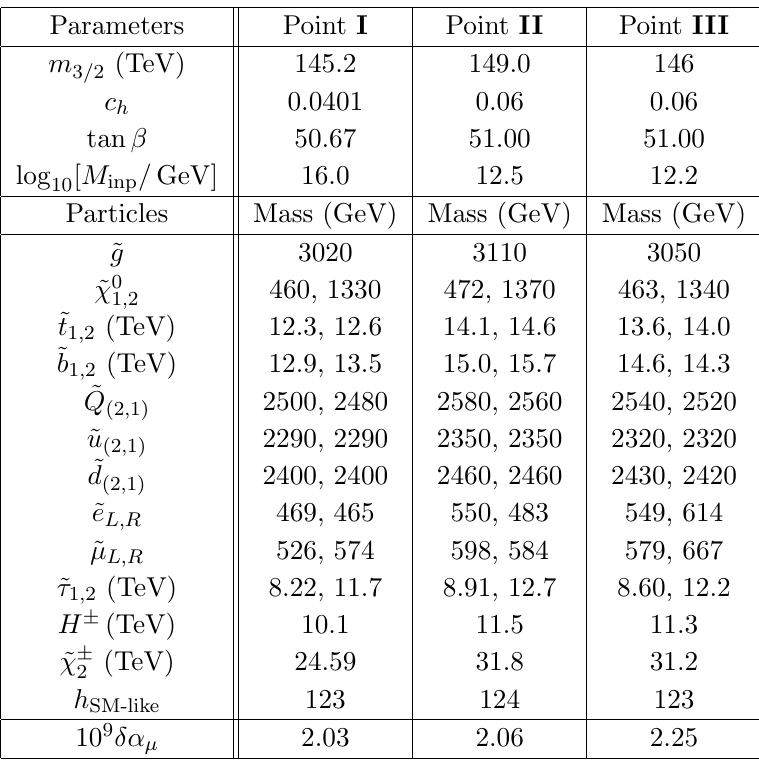
. For the mass of ~ Q , the average of the up and (2 ; 1) (2 ; 1) p m ~ m ~ , respectively. t 1 t 2